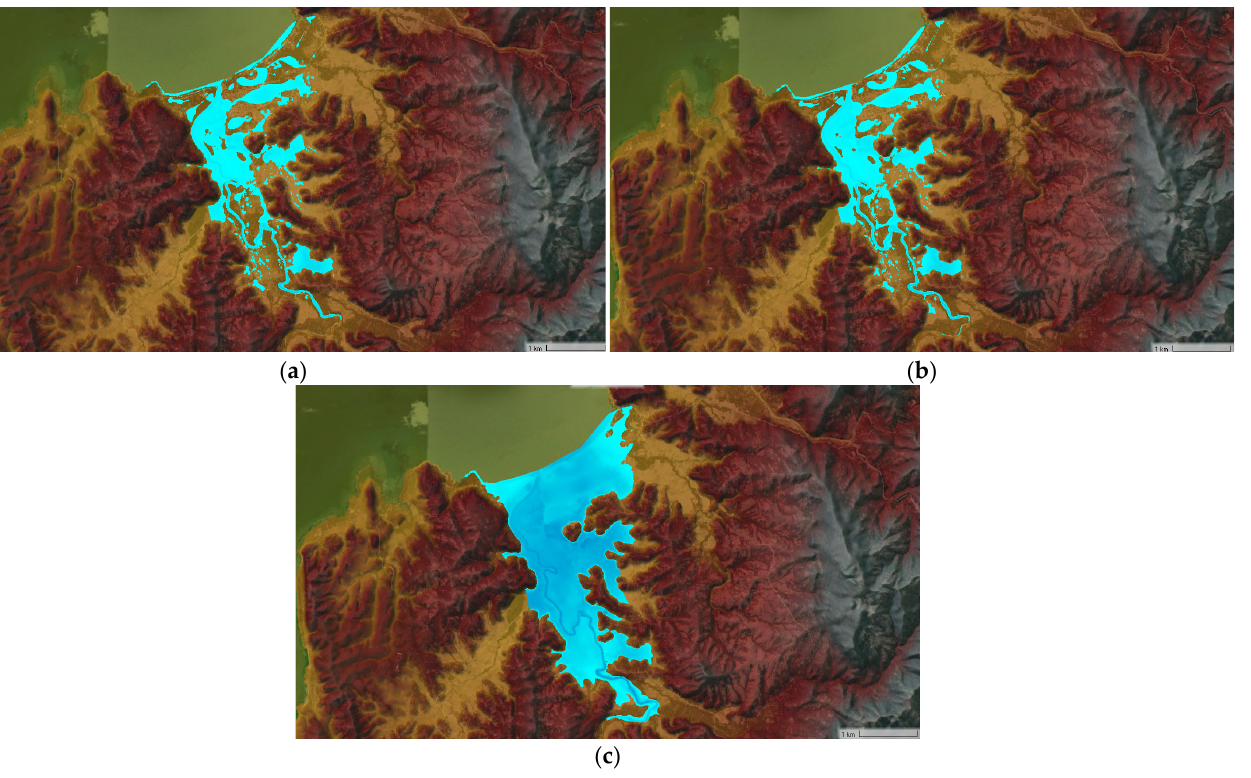
Figure 6. Simulation of maximum flood depth in the main river (Bangon River) of Odiongan, Rom ‐ blon using HEC ‐ RAS for ( a ) 25 years, ( b ) 50 years, and ( c ) 100 ‐ year